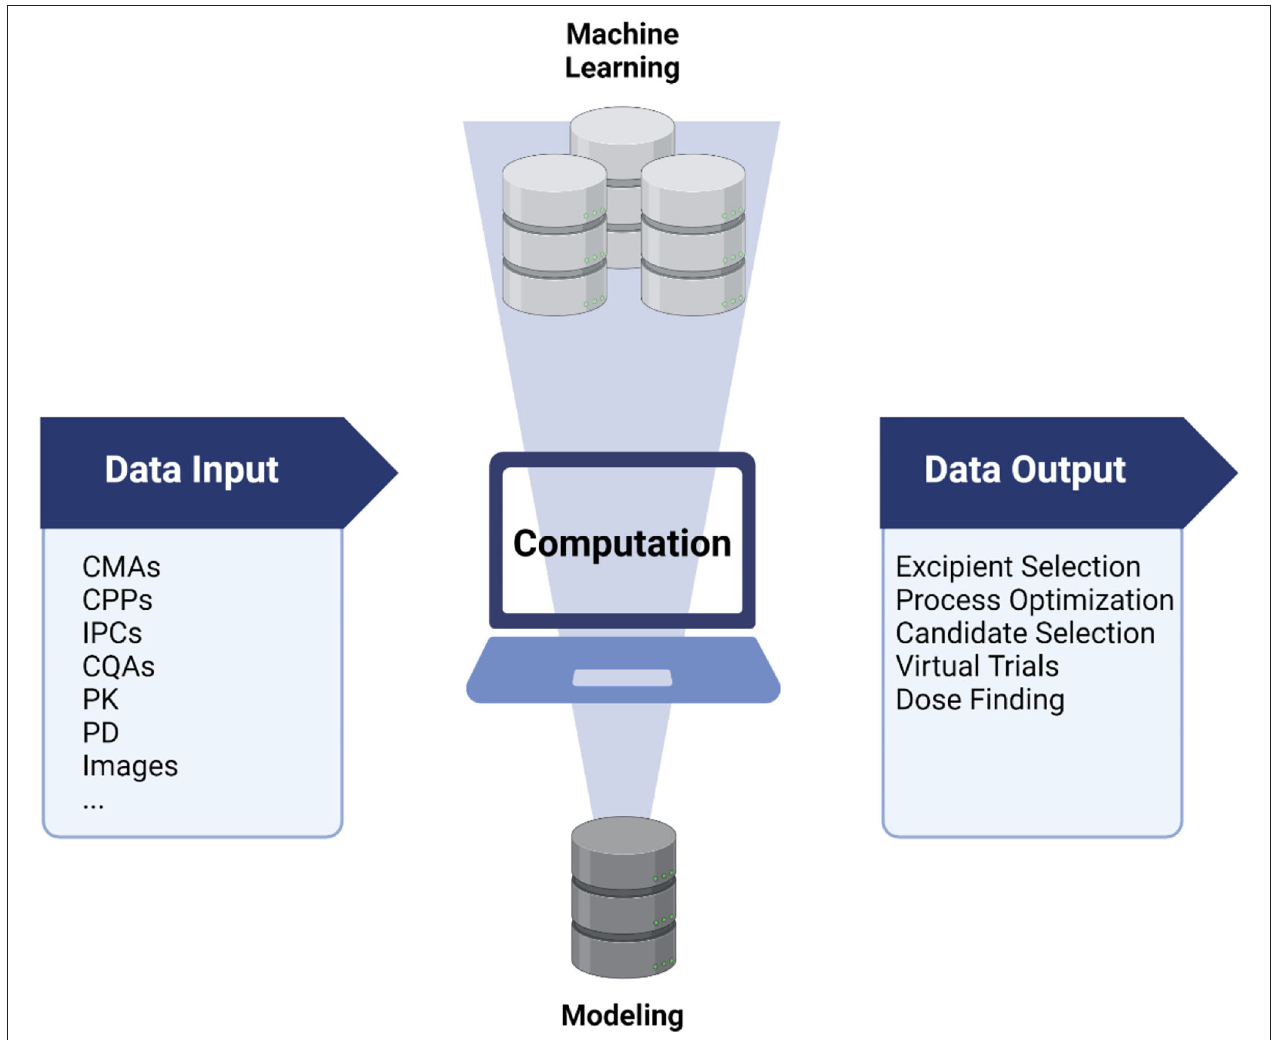
FIGURE 1 | Machine learning and modeling in nanomedicine development include a wide variety of data sources that can be compiled by several algorithms. Machine learning and artificial neuronal networks often require larger data volumes than a conventional modeling approach. Created with www.Biorender.com.